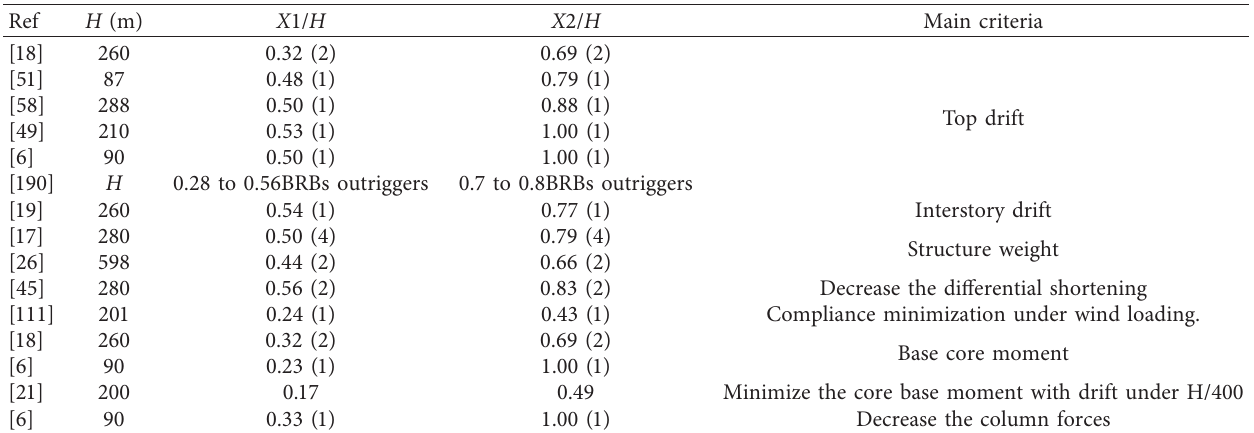
Table 5: RC core walls with two steel outrigger trusses.